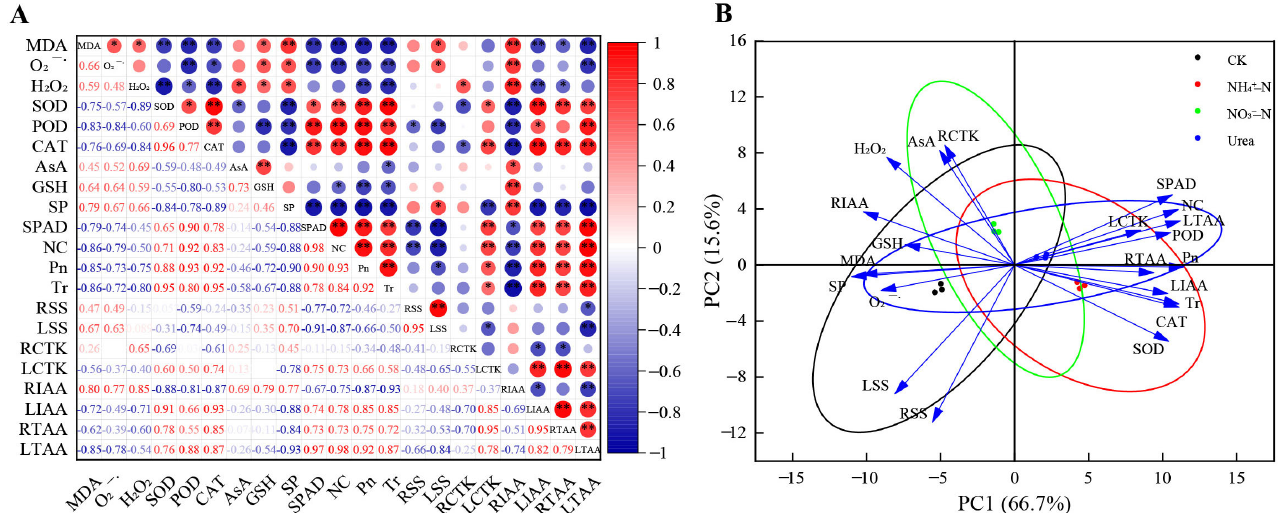
Figure 6. ( A ) Correlation matrix of the physiological indicators. The results were derived from the Pearson correlation analysis. NC, nitrogen content; RSS, soluble sugar in roots; LSS, soluble sugar in leaves; RCTK, cytokinin in roots; LCTK, cytokinin in leaves; RIAA, auxin in roots; LIAA, auxin in leaves; RTAA, total amino acid in roots; LTAA, total amino acid in leaves. * represents a significant correlation at the 0.05 level and ** represents a significant correlation at the 0.01 level. ( B ) PCA score chart of the physicochemical properties of blackberry with di ff erent N forms.